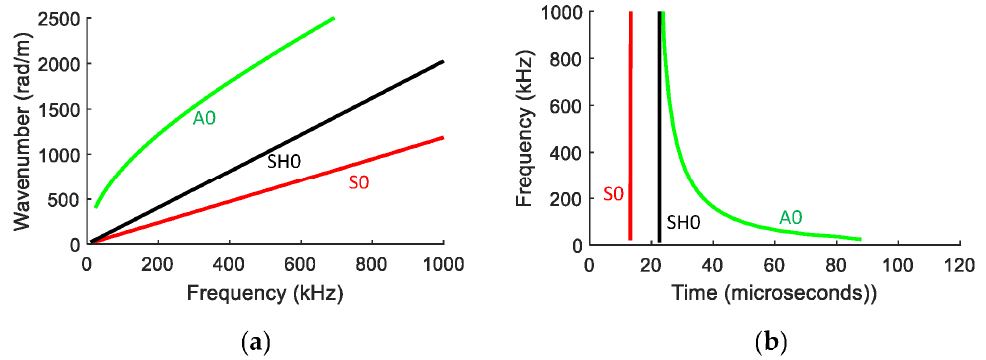
Figure 3. ( a ) Theoretical wavenumber–frequency dispersion curve for 0.6 mm thick aluminium plate. ( b ) Corresponding frequency vs. arrival time 70 mm from the source.